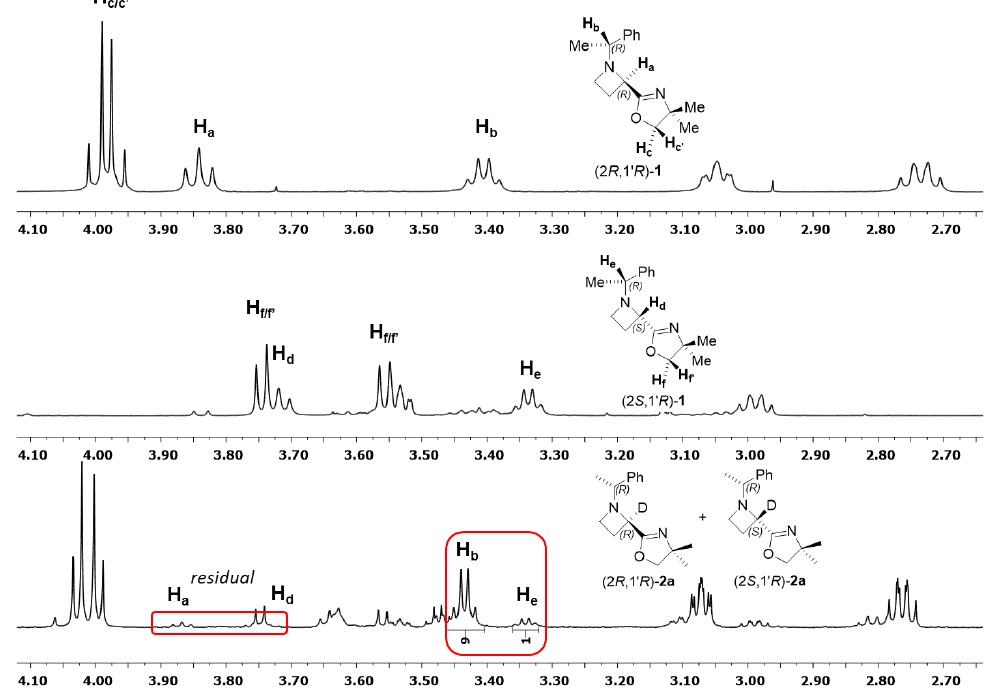
Figure 1. Stereo-convergence for the lithiation/deuteration sequence of (2 R , 1′ R )- 1 and (2 S , 1′ R )- 1 . In Scheme 3, it is reported that the epimerization process involved the lithiated azet- idines (2 R , 1′ R )- 1-Li and (2 S , 1′ R )- 1-Li . In particular, the process must involve four different species resulting, respectively, from two C-Li inversions and two N-R inversions. In fact, NOESY experiments confirmed that, in starting azetidines (2 R , 1′ R )- 1 and (2 S , 1′ R )- 1 , the oxazolinyl ring and the N -phenylethyl group are set in an anti-arrangement [25]. This sug- gests that starting from (2 R , 1′ R )- 1 , upon deprotonation, trans -(2 R , 1′ R )- 1-Li could be gen- erated first and then undergo either a C-Li inversion producing syn -(2 S , 1′ R )- 1-Li or N-R inversion giving syn -(2 R , 1′ R )- 1-Li . On this basis, N-R inversion on syn -(2 S , 1′ R )- 1-Li would give anti -(2 S , 1′ R )- 1-Li , which, upon C-Li inversion, would converge again to syn -(2 R , 1′ R )- 1-Li in a sort of looping process. This dynamic scheme would explain the 90:10 diastereo- meric ratio and the stereo-convergence towards (2 R , 1′ R )- 2a that was observed in the lithi- ation/deuteration sequence of both (2 S , 1′ R )- 1 and (2 R , 1′ R )- 1 . However, the configura- tional lability observed in these lithiated azetidines is in striking contrast to the configu- rational stability observed for the corresponding oxazolinylaziridines (Scheme 3b).